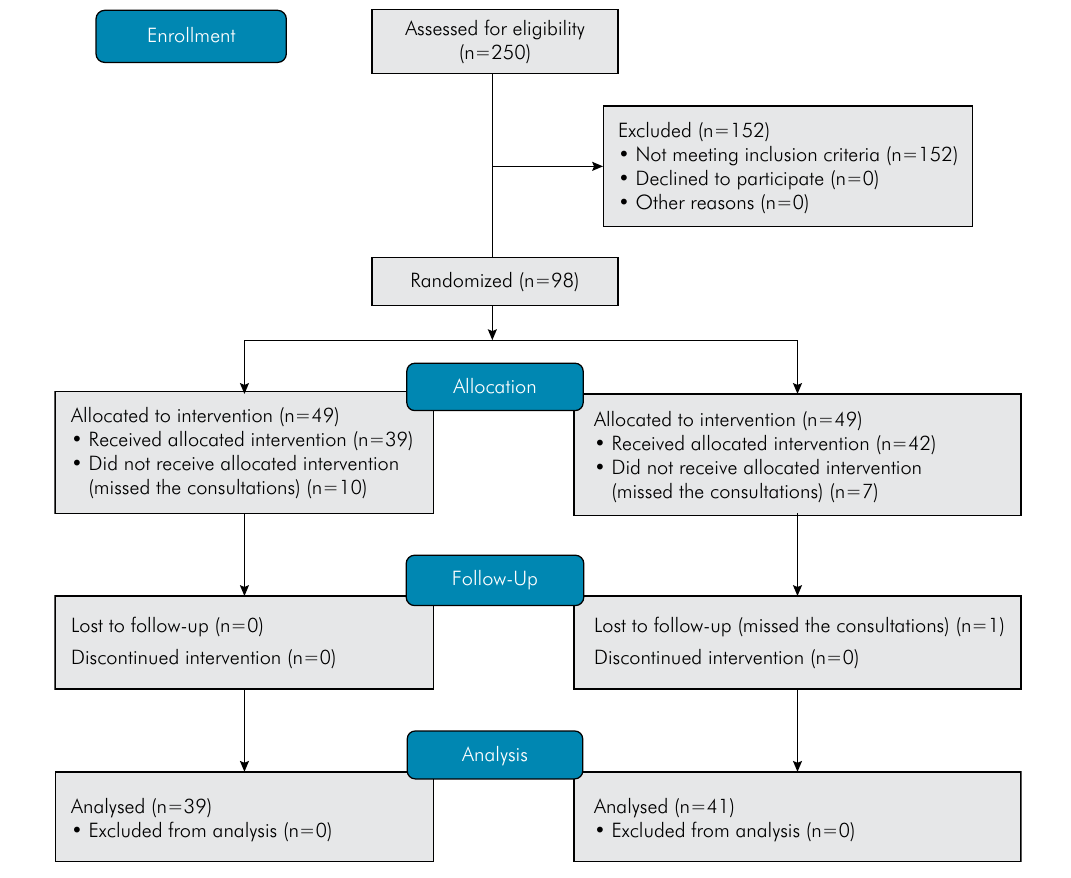
Figure. Consort flow